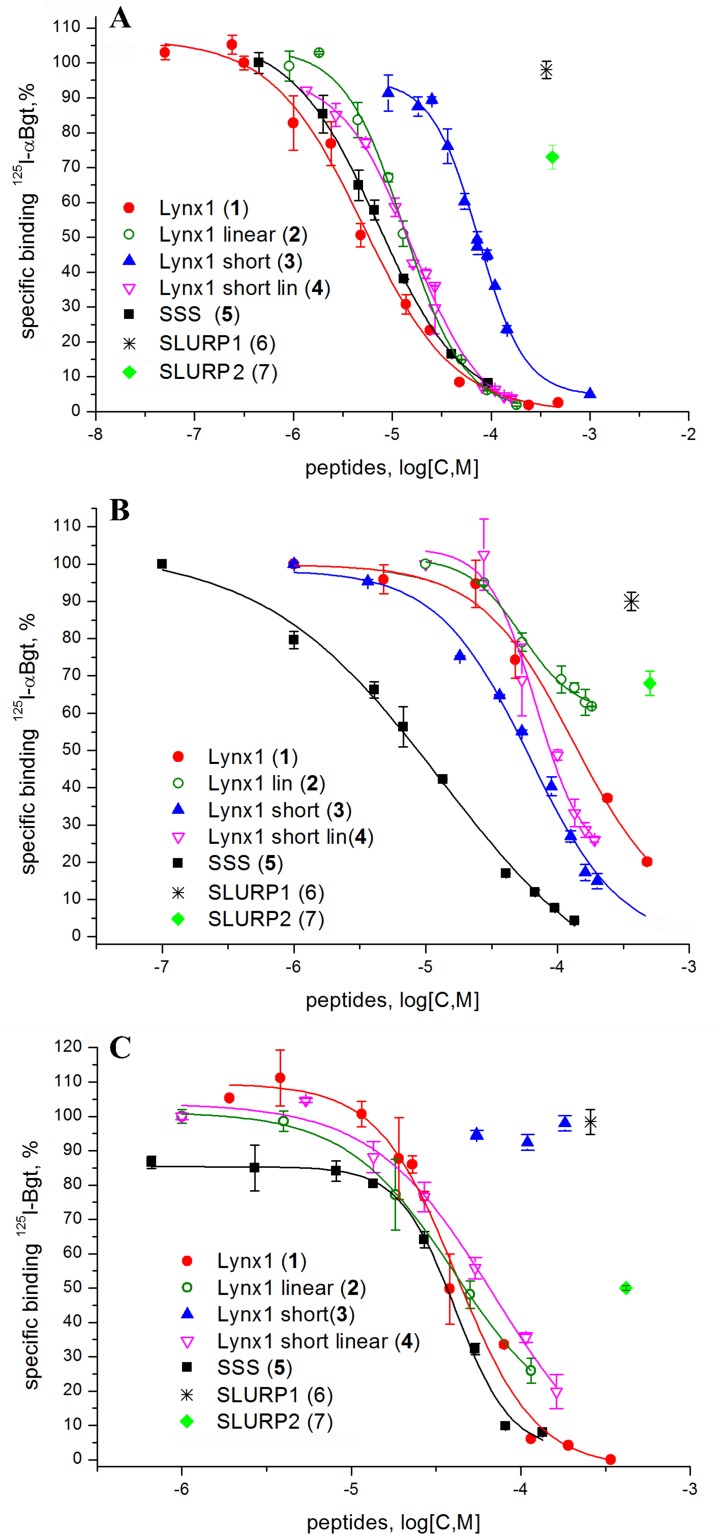
Competition of [125I]-labeled αBgt with Lynx1 peptides and SSS fragment for binding to (A)
Torpedo californica nAChR, (B) human α7 nAChR expressed in the GH4C1 cell line, and (C) ligand-binding domain (LBD) of the human nAChR α9 subunit. IC50 values and 95% confidence interval (CI 95%) for these data are presented in
Table 2
. Each data point represents the mean ± SEM of three to four independent experiments.